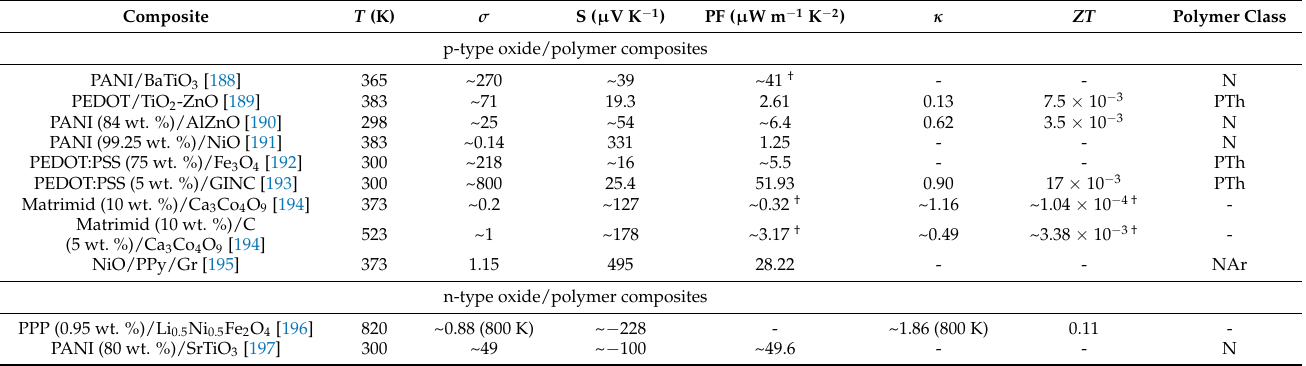
Table 8. Thermoelectric properties of various oxide/polymer composites at a stated temperature ( T ). GINC = graphene–iron oxide nanocomposite. Gr = Graphene. Polyparaphenylene = PPP. σ is electrical conductivity, S is the Seebeck coefficient, PF is the power factor and κ is the thermal conductivity. All values are reported at ZT max , figure of merit at maximum or PF max where applicable. † Calculated from literature